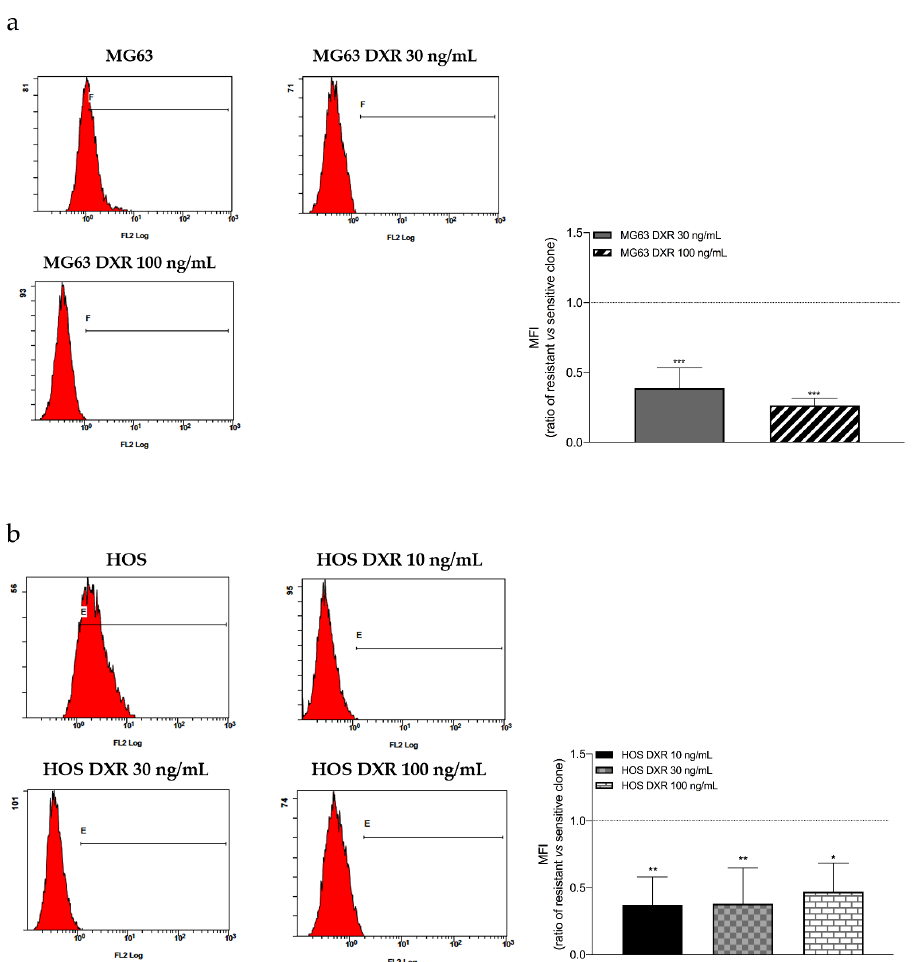
Figure 4. ( a ) Evaluation of ROS levels by flow cytometry. Representative cytograms and relative quantification showing the fluorescence intensity of Mitosox 5 µ M in MG63, MG63 DXR 30 ng/mL, and MG63 DXR 100 ng/mL cells. The horizontal dotted line refers to normalized untreated cells. ( b ) Evaluation of ROS levels by flow cytometry. Representative cytograms and relative quantifica- tion showing the fluorescence intensity of Mitosox 5 M in HOS, HOS DXR 10 ng/mL, HOS DXR 30 ng/mL, HOS DXR 100 ng/mL cells. The horizontal dotted line refers to normalized untreated cells. Data represent media ± SD of three different experiments. * p < 0.05, ** p < 0.01, *** p < 0.001, resistant “vs.” sensitive clones. The reduced mitochondrial mass and biogenesis and the reduced ROS production in resistant cells suggest that these cells have reduced mitochondrial oxidative